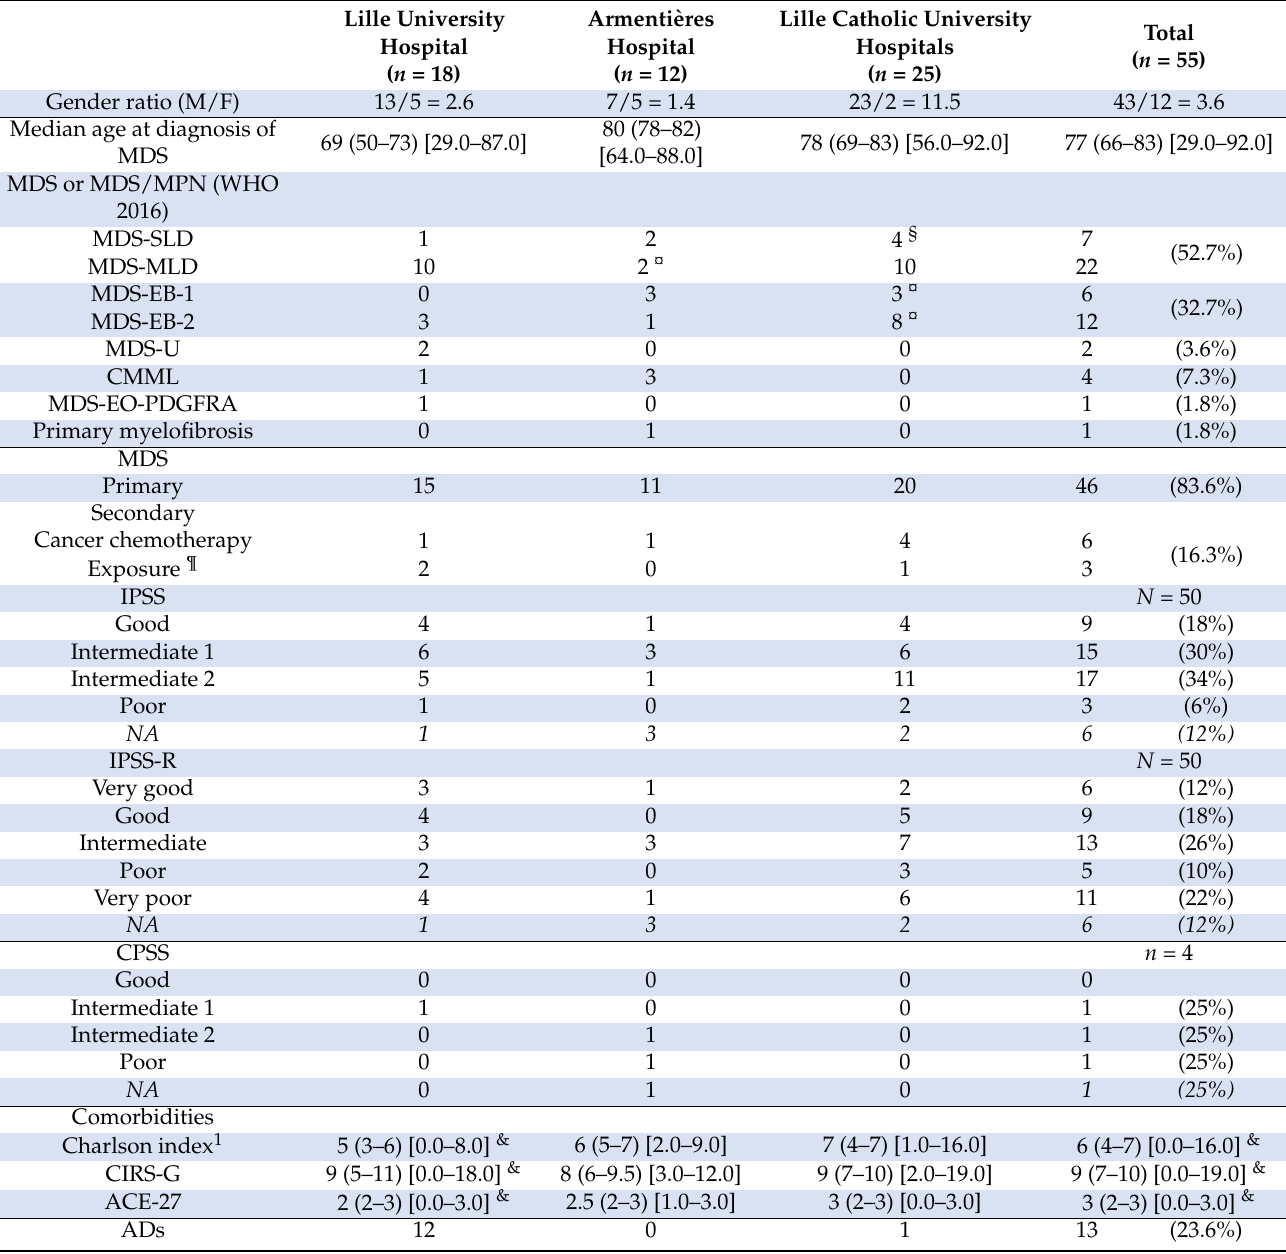
Table 1. General characteristics of